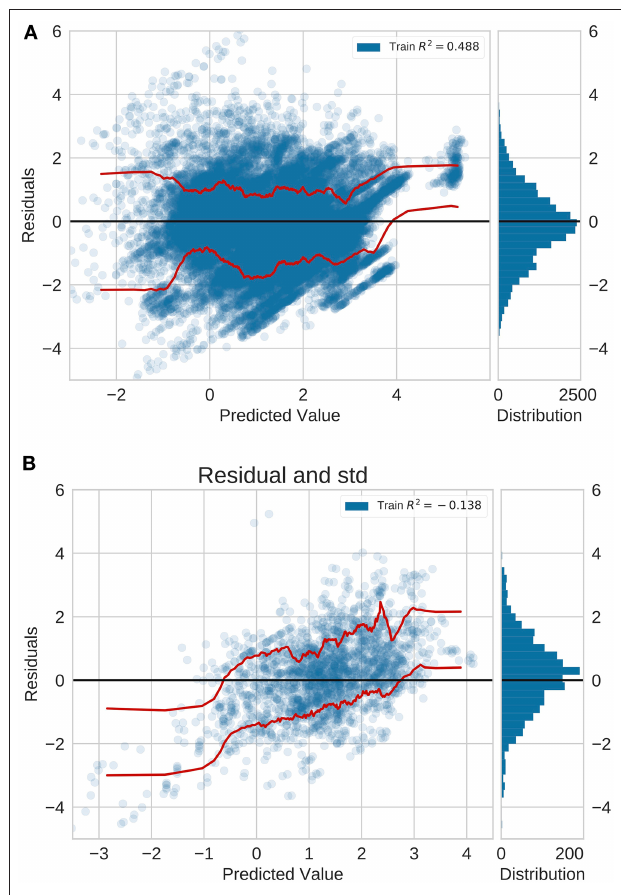
FIGURE 3 | Residual plots for previously unseen diseases on data from (A) GBD and (B) peer-reviewed journals. Red lines indicate the standard deviation.